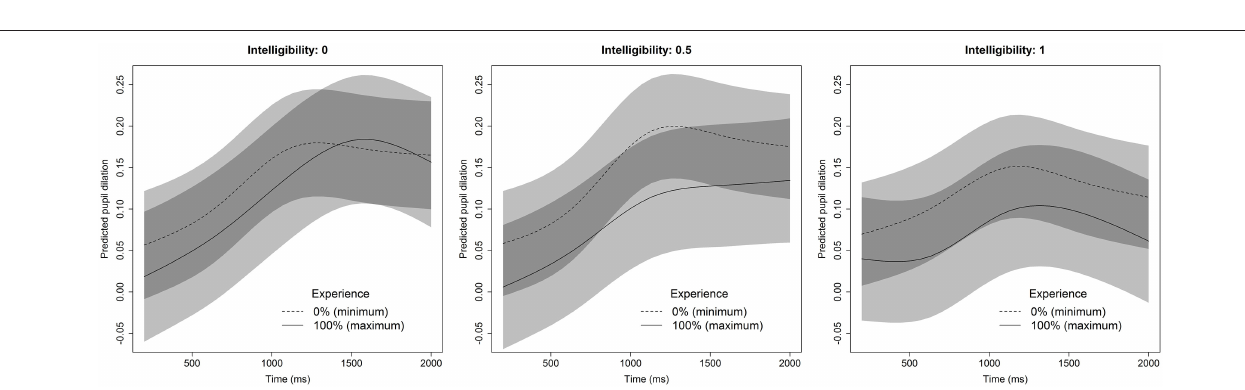
that the listeners always attempt to process the speech regardless of